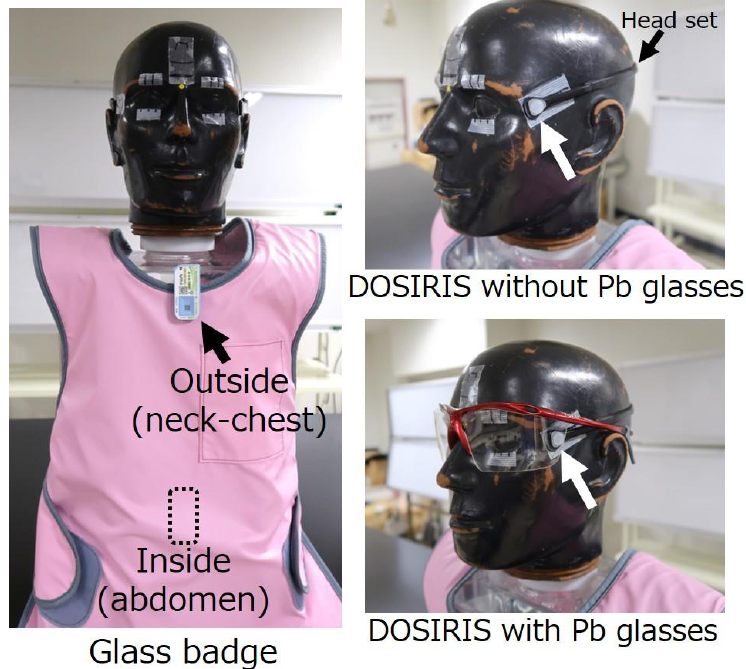
Figure 1. Medical staff phantom and layout of personal dosimeter and Pb glasses.